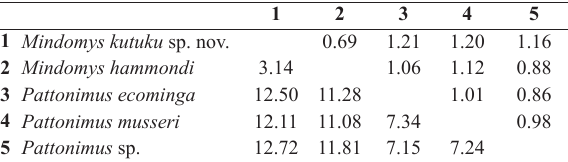
Table 2. Uncorrected genetic distances in percentages (p-dis- tances) between Mindomys kutuku sp. nov. (MECN 5809) and the phylogenetically closest species. Distances based on the cytochrome b gene (1140bp). The values on the over diagonal represent the standard